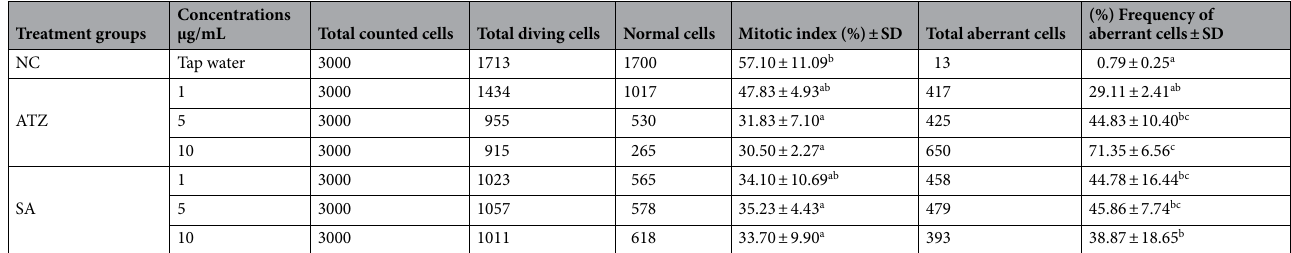
Table 4. Percentage of mitotic cell division in Allium cepa root tips after treatment with atrazine and sodium azide. NC negative control, ATZ atrazine, SA sodium azide. Data are mean ± SD of three replicates. Different alphabets (a, b and c) are significantly different at (p < 0.05), as determined by Tukey HSD test.